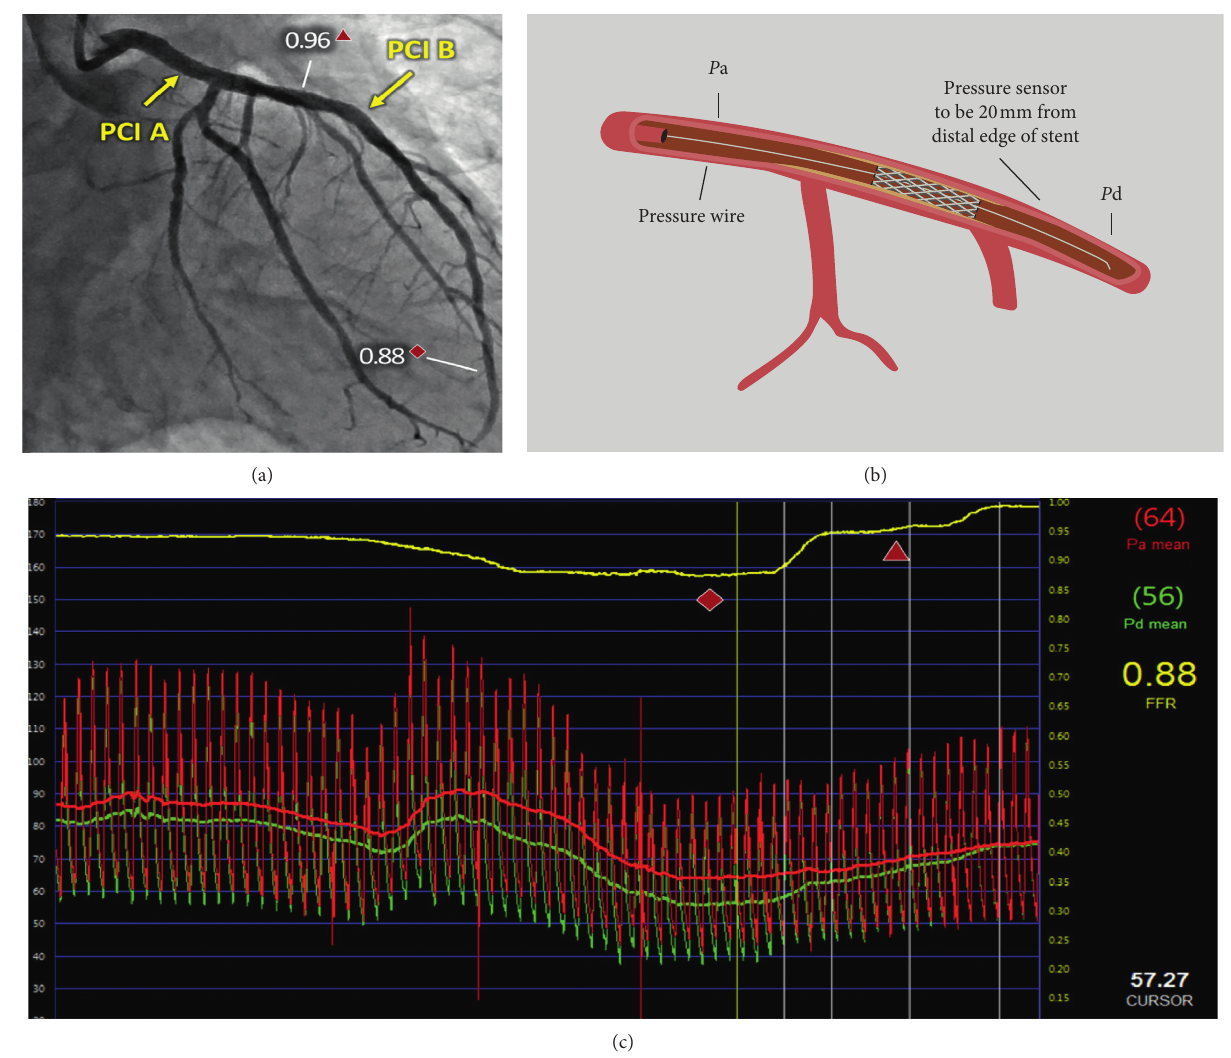
Figure 2: (a) Angiographic image of post-PCI FFR in the distal left main stem and mid-left anterior descending artery (b) Conceptual representation of post-PCI pressure measurements. FFR is calculated as a ratio of distal coronary pressure ( P d ) to aortic pressure ( P a ). / P . (c) Pressure curve from post-PCI FFR measurement in the patient from part A, displaying pressure drops across the two stents. FFR � P d a (a) and (c) are adapted from Ihdayhid et al. [30] with permission. Copyright © 2016,